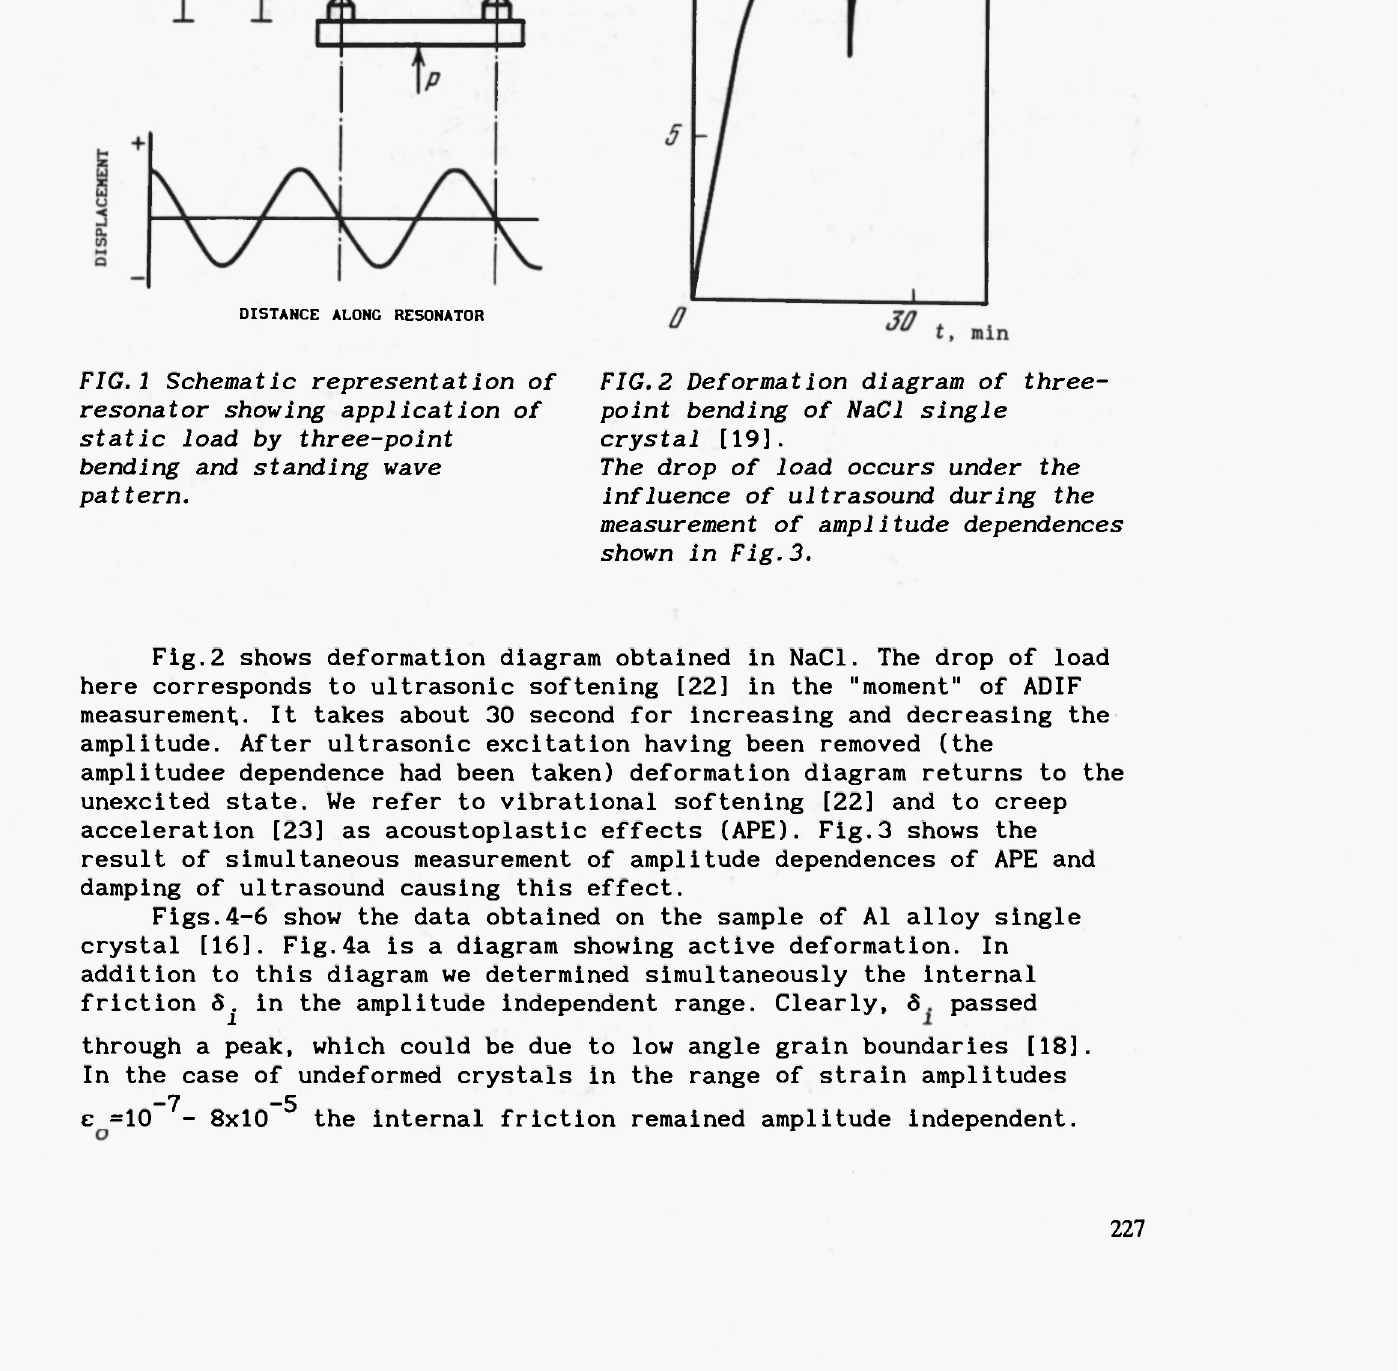
FIG.1 Schemat ic represent at ion of resonator showing application of static load by three-point bending and standing wave pattern.